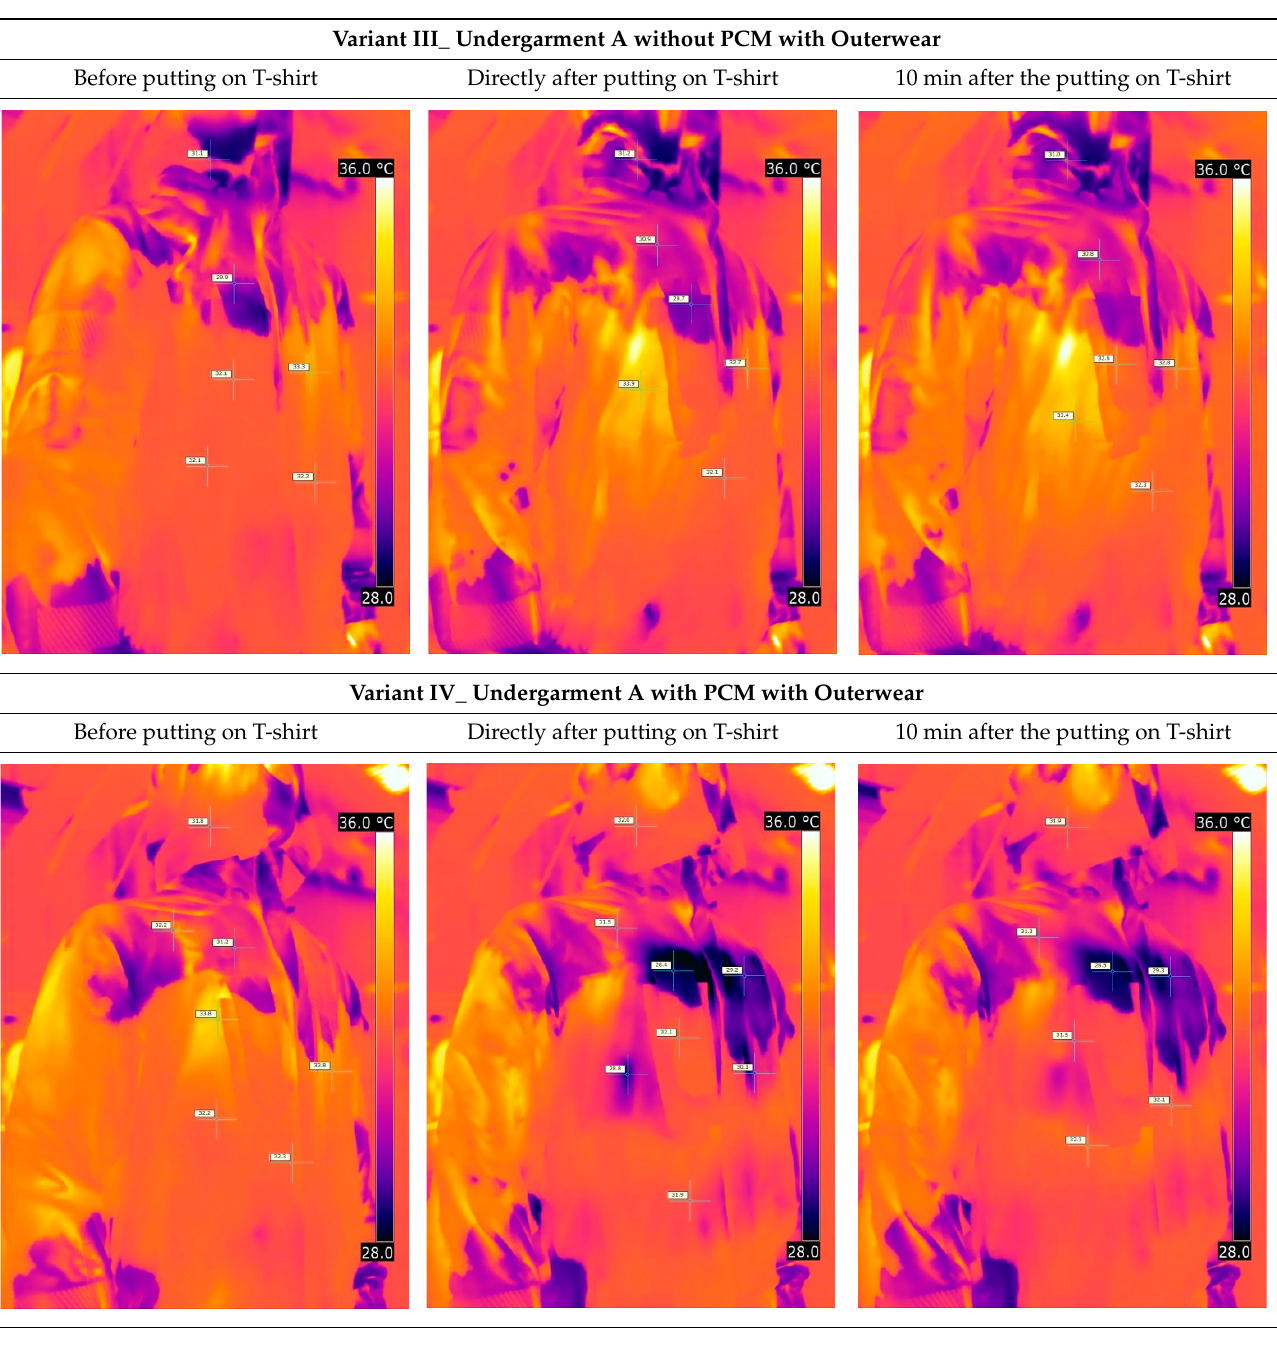
Table 3. Pictures from thermal imaging cameras for variants III and IV.